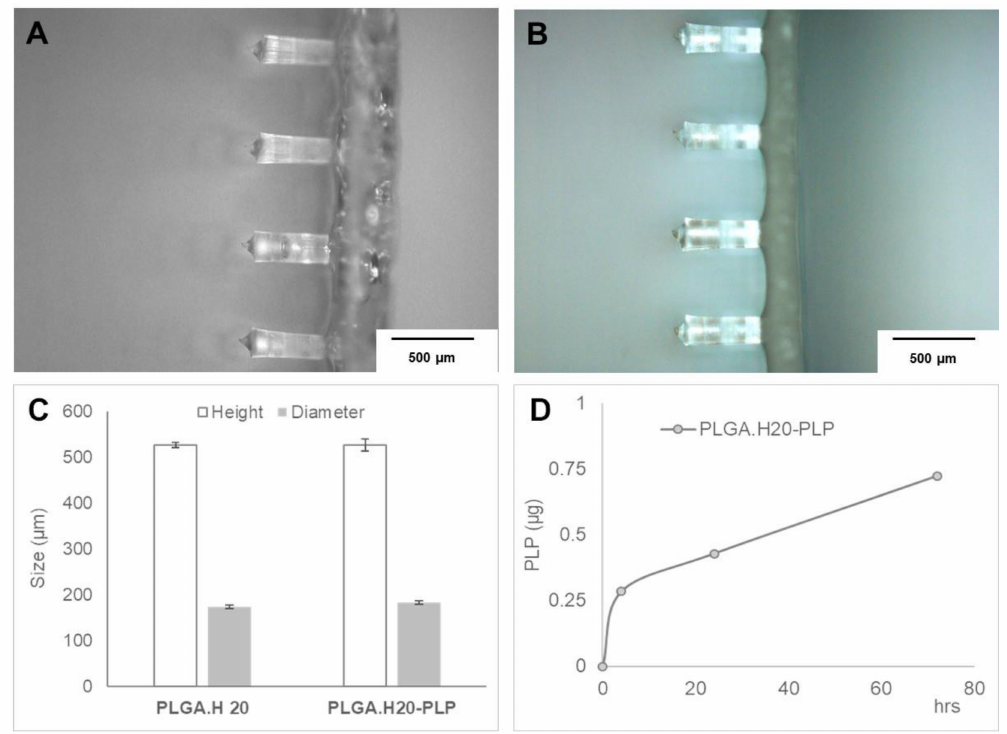
Figure5. PolymermicroneedlesloadedwithPLGA.H20nanoparticles. ( A , B )Opticalmicroscopyimages of microneedles loaded with ( A ) plain or ( B ) PLP-loaded PLGA.H20 nanoparticles. ( C )